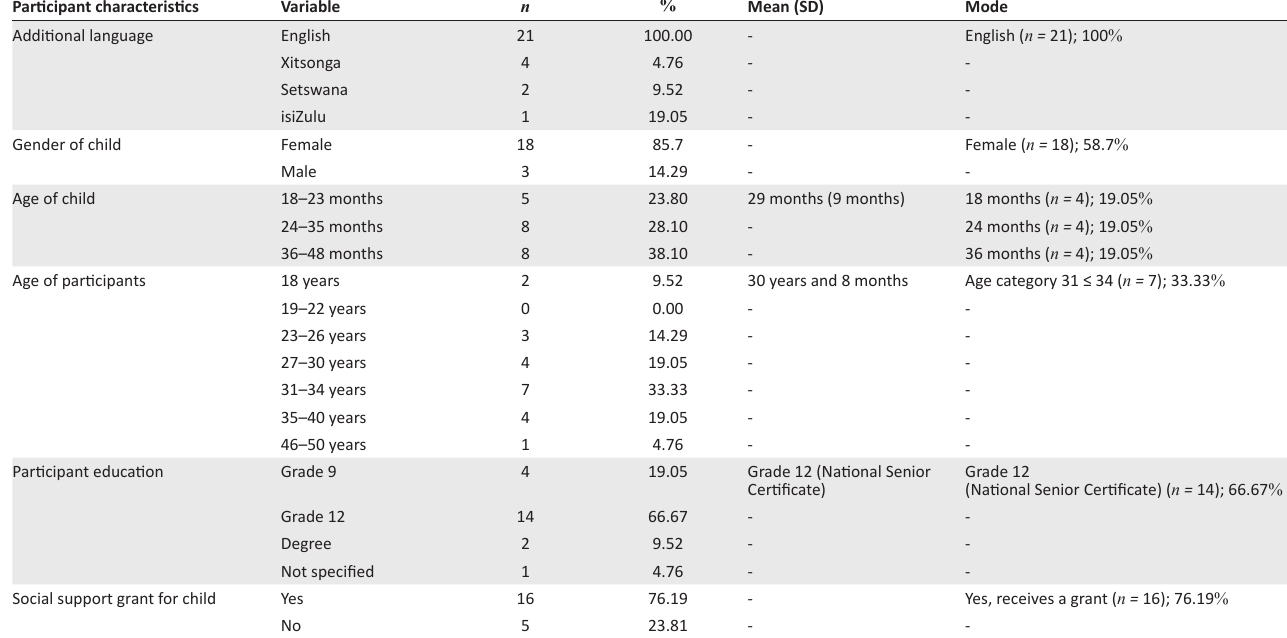
TABLE 1 : Participant characteristics ( n =